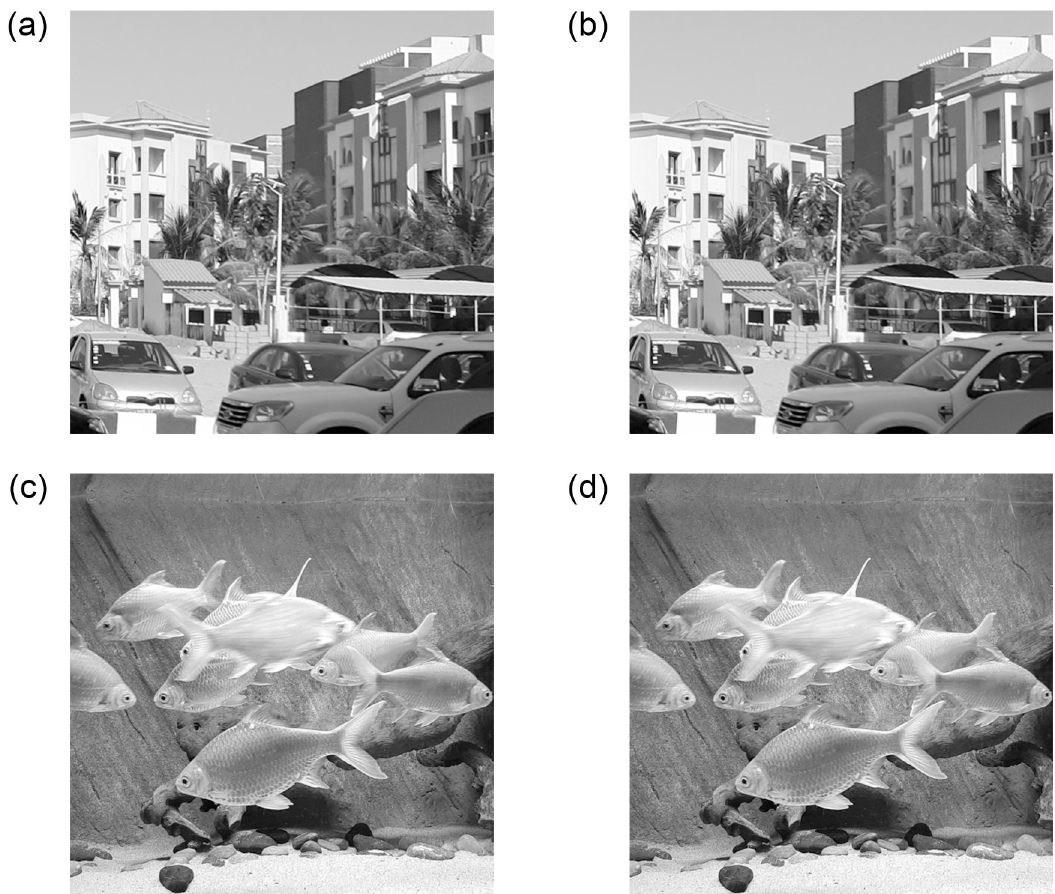
Fig 6. Example of embedded and decoded versions of test images of size 512 × 512 × 8, (a,b) City and (c,d) Fish (Original test images are from author’s collection).